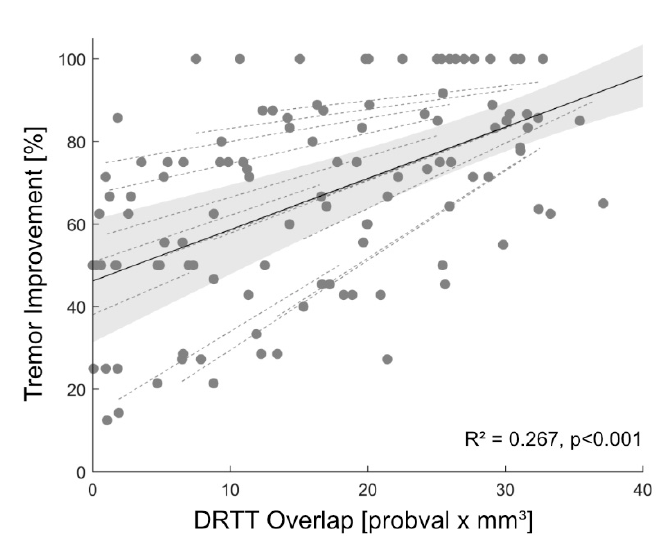
Figure 2. Prediction of Tremor Improvement. Linear mixed-effects model (black) and 95% confidence interval (gray) between tremor improvement and overlap with the individual dentatorubrothalamic tract (DRTT). Random effects for each individual hemisphere are also shown (dashed, gray). Abbreviations: DRTT = dentatorubrothalamic tract.